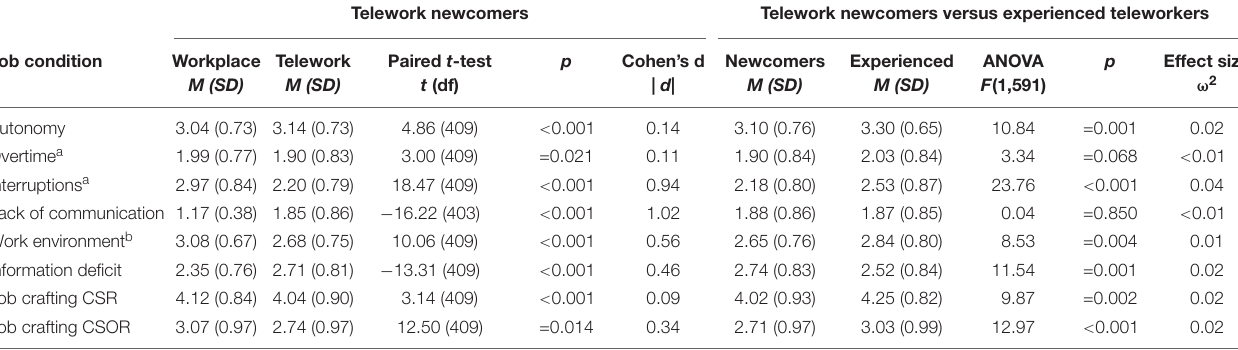
TABLE 2 | Comparison between the job conditions and job crafting behaviors for newcomers and experienced teleworkers. Telework